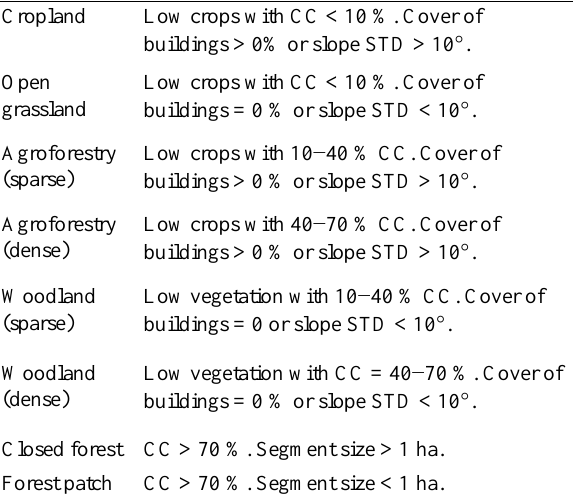
Table 1. Land cover classes based on LCCS at level-0.